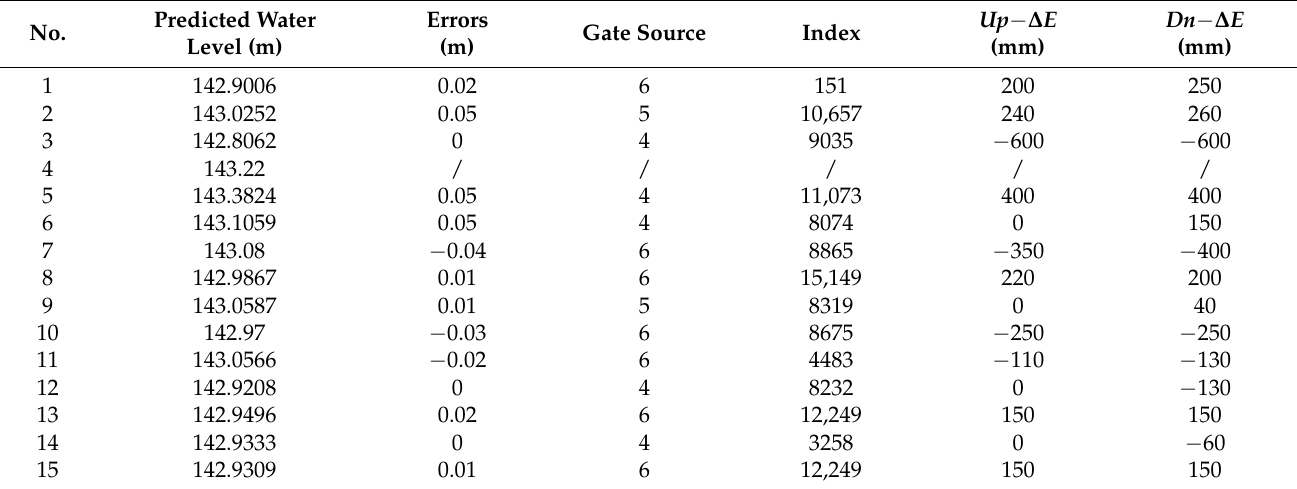
Table 10. Final predicted water level and error for each